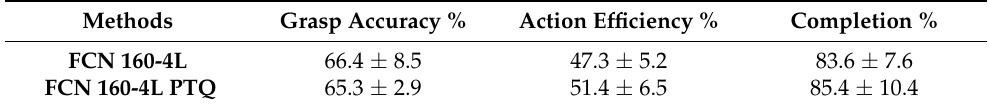
Table 2. Testing results for quantized system on a simulated environment.